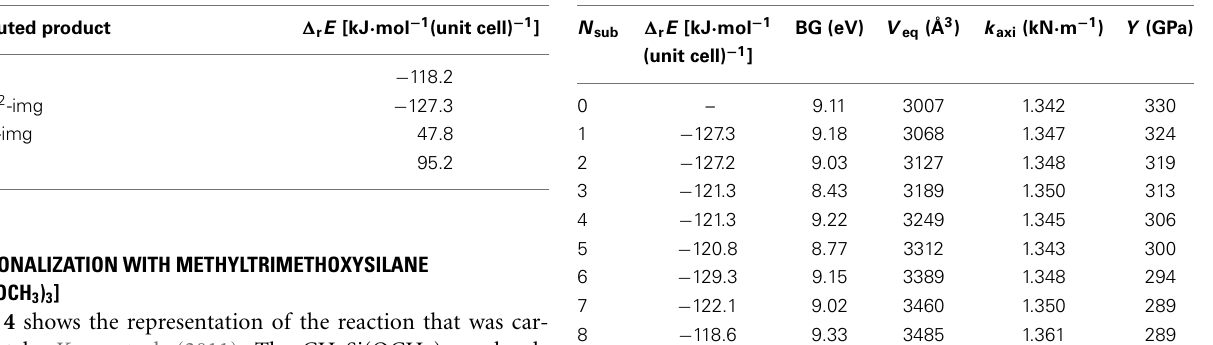
Table 2 | Mean values and SD of the reaction energy per number of substitution ( N sub )